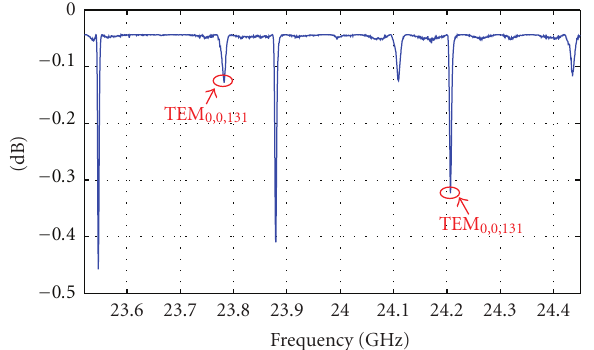
Figure 10: Measured return loss for the case L = 3 . 5mm.